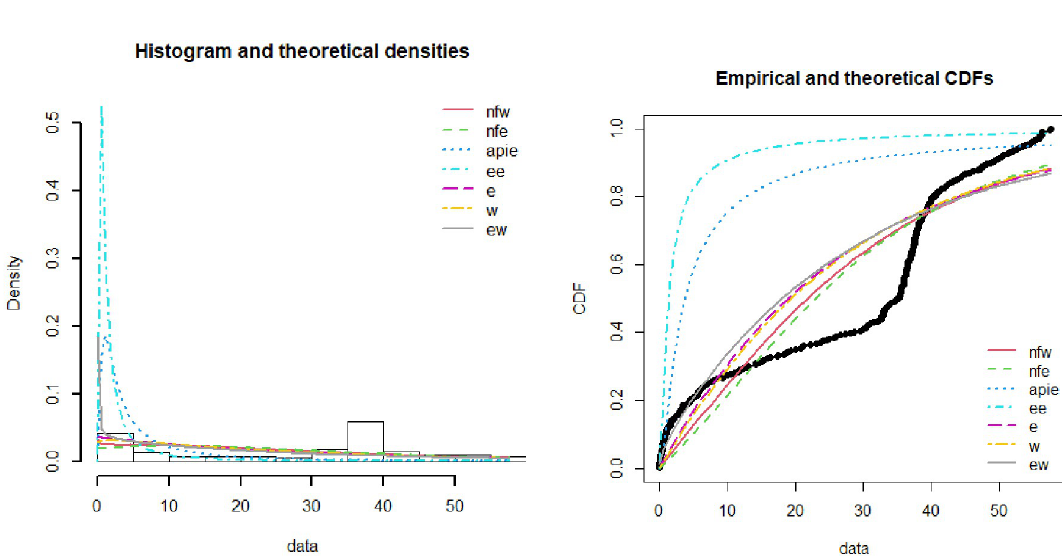
Fig 6. Theoretical and empirical PDF and CDF of